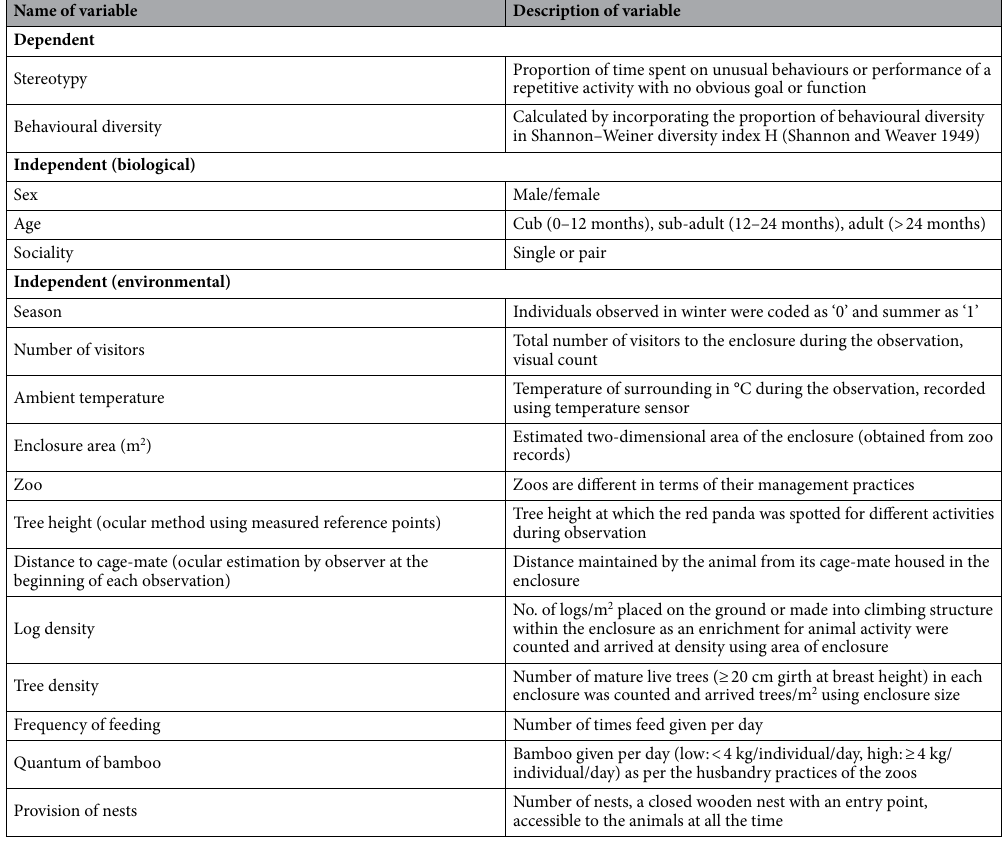
significant difference in ambient temperature between winter (as low as zero) and summer (as high as 25 °C), with which the pandas alter their behaviours. Accounting season as one of the variables reflects this behaviour adaptation if any. The season considered in the study represent the actual observation time and its effect on the behaviour. Statistical analysis. Statistical analysis was carried out using SPSS for Windows ( Version 16 ) and R ( Version 3.4.1 ). Before testing for differences in the levels of stereotypy and behavioural diversity due to various biological and environmental variables, we checked the data for normality. The data for the dependent variables (stereotypy and behavioural diversity) were not normally distributed, so we performed non-parametric tests. For the behavioural diversity data set we excluded two outlier data points with respect to the tree density variable. The univariate dependence of stereotypy and behavioural diversity on biological and environmental factors was tested using the Mann–Whitney U test (for factors with two categories) and Kruskal Wallis H test (for factors with three categories). For the season category (winter and summer) we coded subjects as 0 and 1; 0 for winter observation and 1 for summer season. The first-order effects of the continuous variables were checked using simple linear regression; in particular, to check the effect of stereotypy on behavioural diversity, we treated the former as independent variable and latter as dependent variable in linear regression. To quantify and assign empirical support to the simultaneous effects of each of the biological and environmental factors, we employed